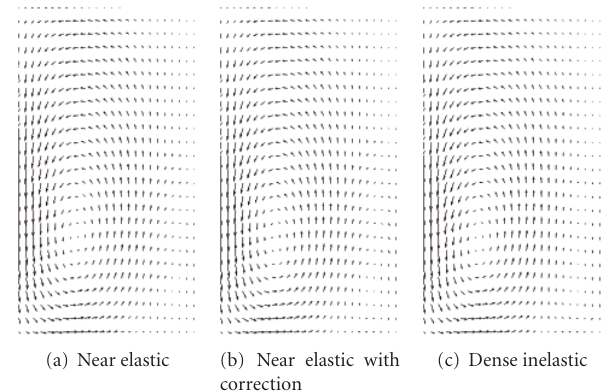
Figure 6: Comparison of normalized velocity vectors in two- dimensional cell for (a) near elastic model (b) near elastic model with modification, and (c) dense inelastic model for V ∗ = 3 .